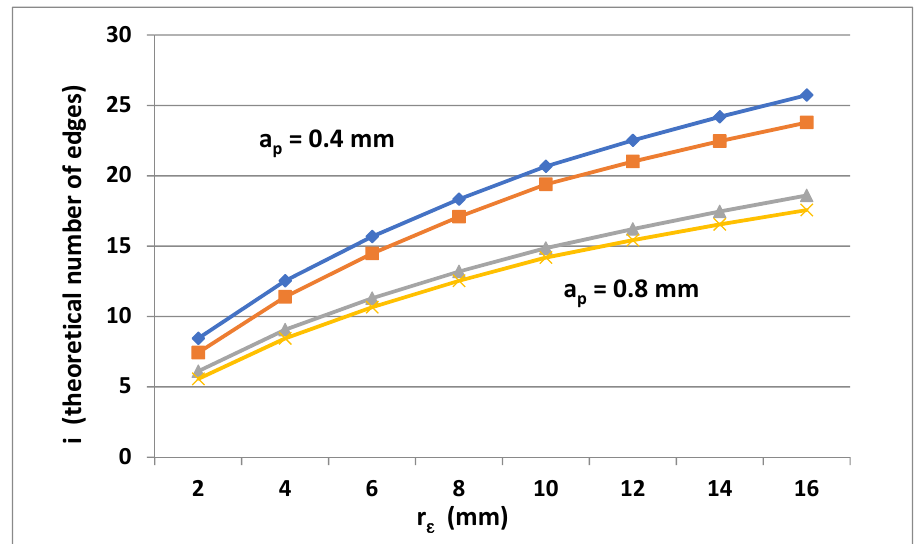
Figure 5. Theoretical number of edges determined by using the round insert α + β rotation for different r ε , f, and a p values.